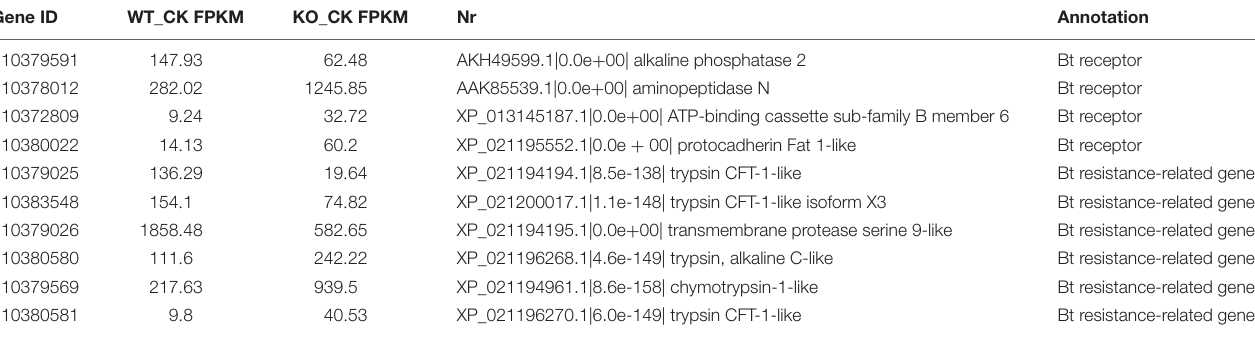
TABLE 2 | Expression levels of Bt receptor genes and Bt resistance-related genes in WT and KO cotton